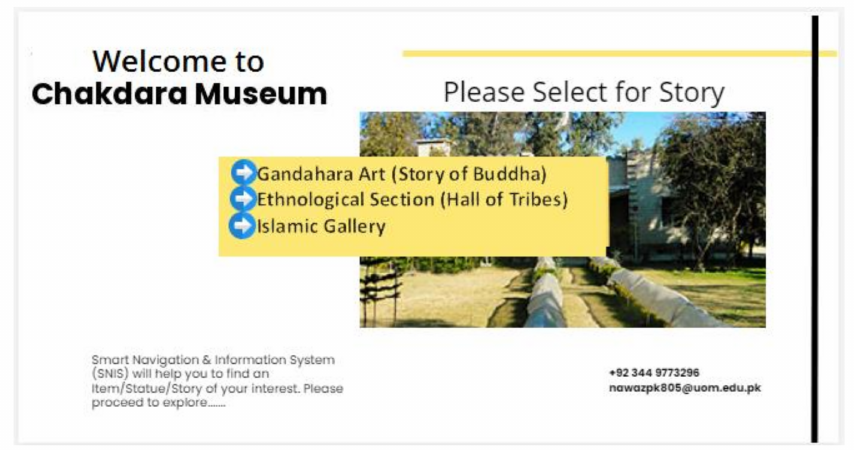
Figure 11. Selecting a section.